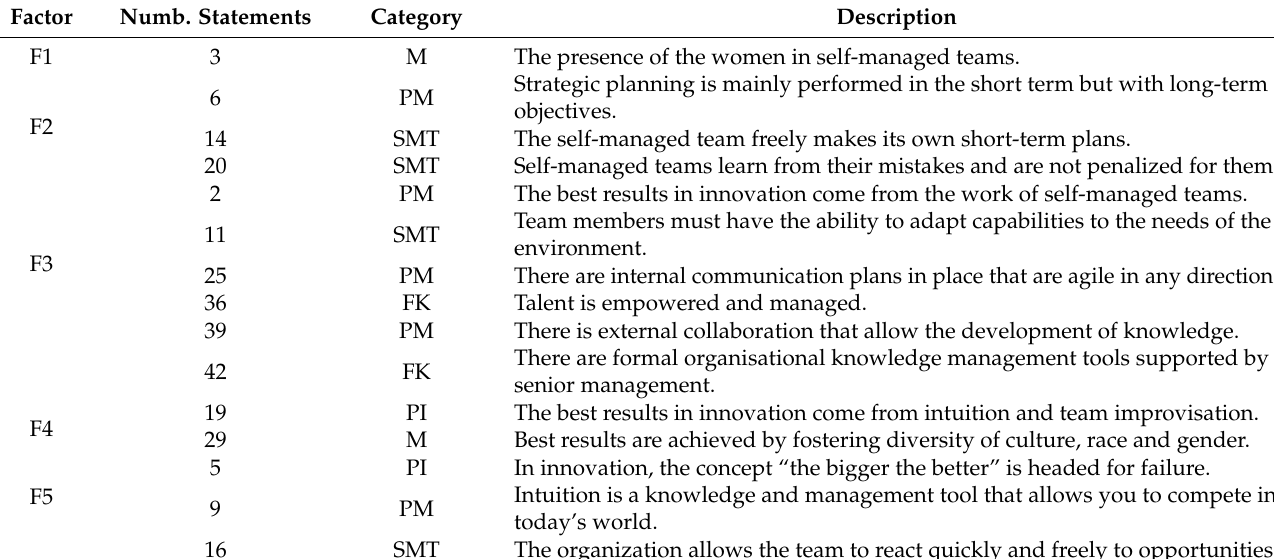
Table 4. Distinctive declarations for each